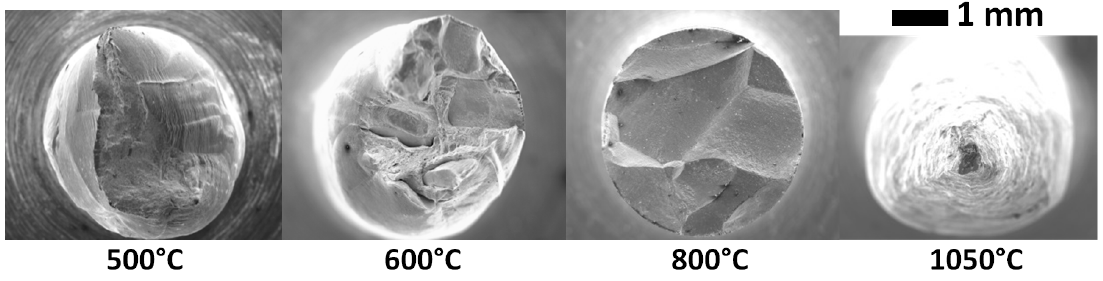
Figure 2: The fracture surfaces of the 9 ppm S specimens, tensile tested at different temperatures.